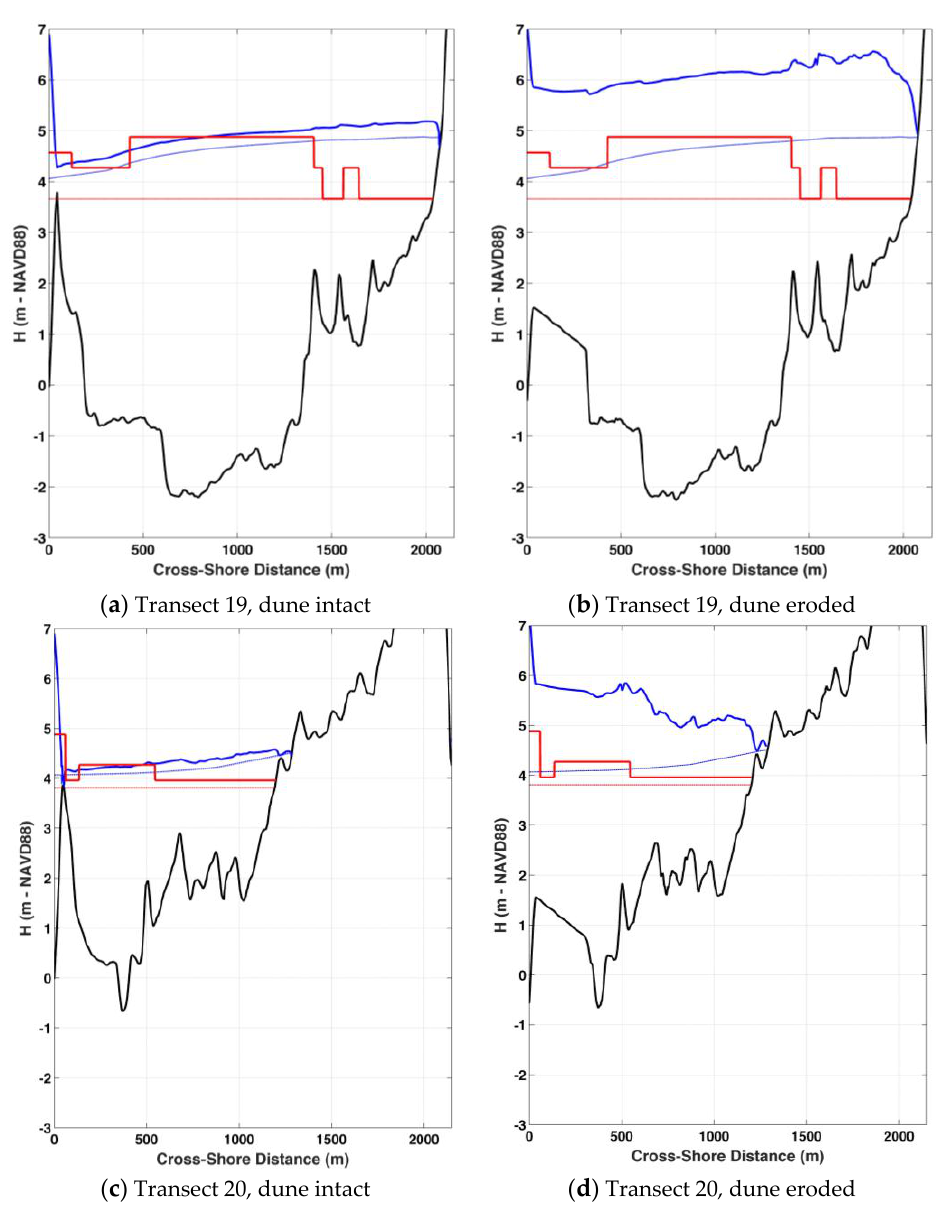
Figure 14. Water elevation (m/NAVD88; BFE, plain; Still Water Elevation Level data (SWEL), dashed) versus landward cross-shore distance (m) along FEMA transects 19 ( a , b ) and 20 ( c , d ) for FEMA calculation (red) and NAST simulations (blue) assuming dune intact ( a , c ) or dune eroded ( b , d ); topography